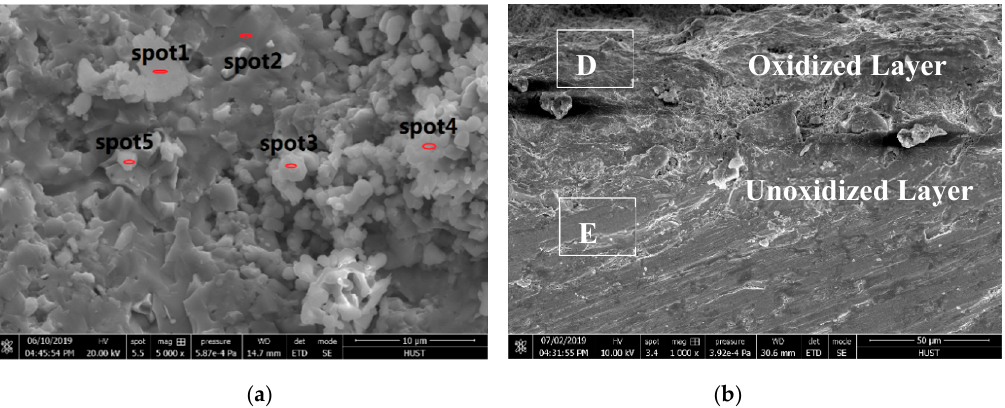
Figure 11. Surface and cross-section morphologies of the oxidized coating at 1100°C for 110 h; ( a ) Surface morphology; ( b ) Cross-section morphology. Table 2. EDS’s results of GH4169 at different positions in Figure 10a (%). Element